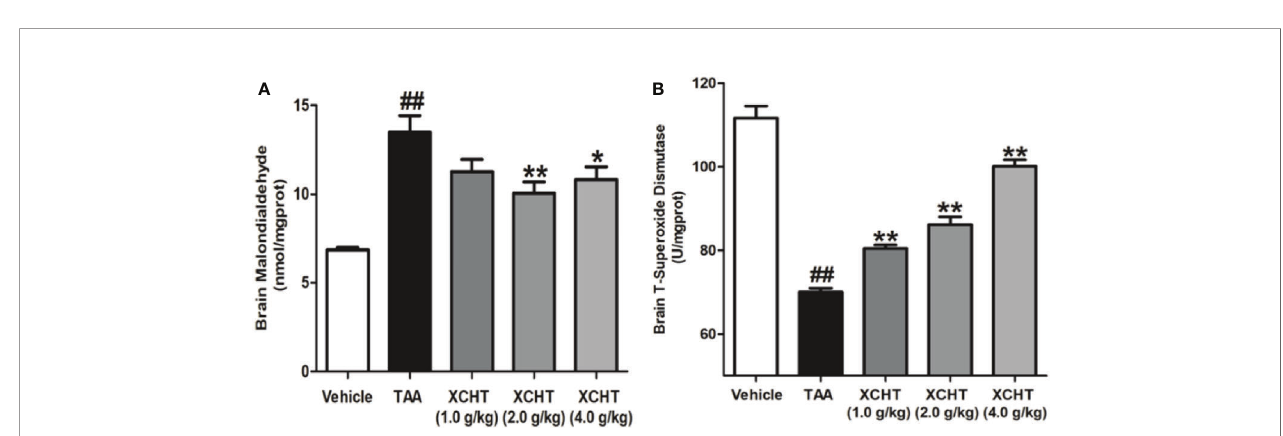
FIGURE 3 | Effects of different doses of XCHT on oxidative stress level [MDA (A) and T-SOD (B) ] in cerebral cortex of TAA induced AHE rats. Data were expressed as mean ± SD (n = 5-7). ## p < 0.01 vs. the vehicle group. *p < 0.05, **p < 0.01 vs. the TAA group.